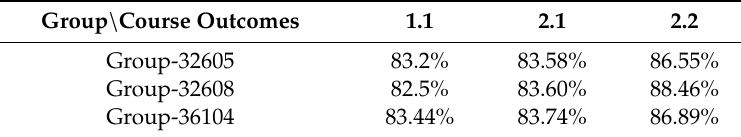
Table 2. Direct assessment